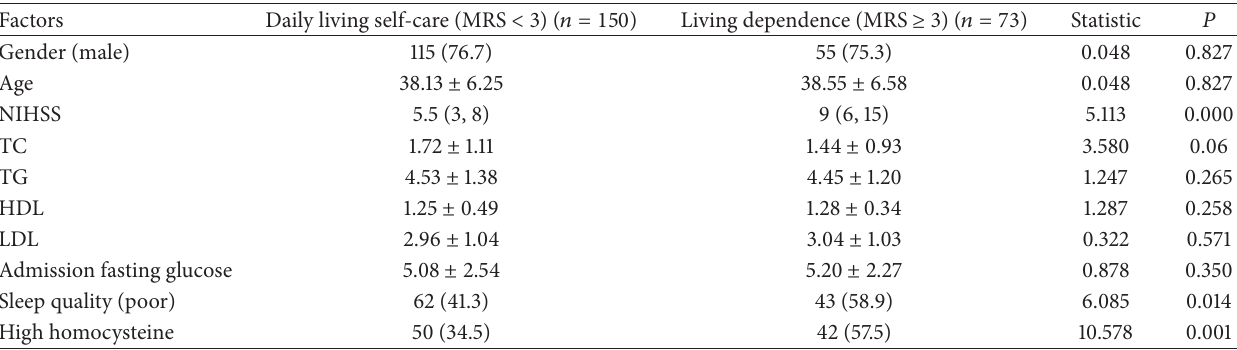
Table 3: Univariate analysis of short-term prognostic factors in youth IS patients. By univariate analysis, NIHSS score, poor sleep quality, and high homocysteine were statistically different between living self-care and living dependent patients ( 𝑃 < 0.05 ).